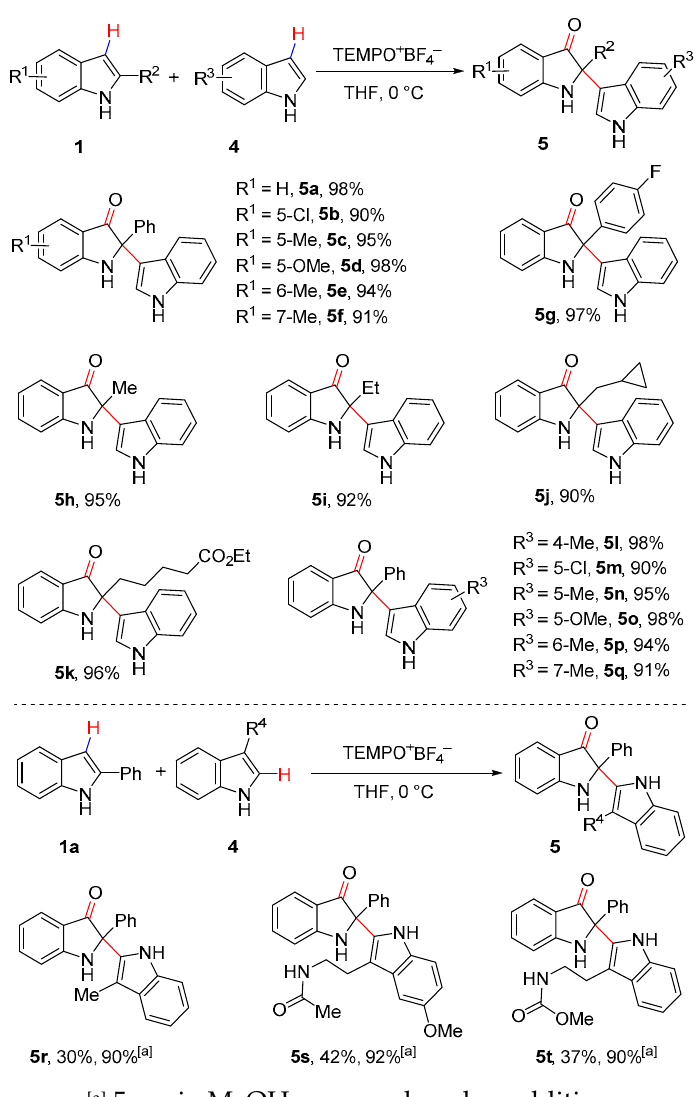
Figure 4. Cross-dehydrogenative coupling of indoles with dissimilar indole substrates.